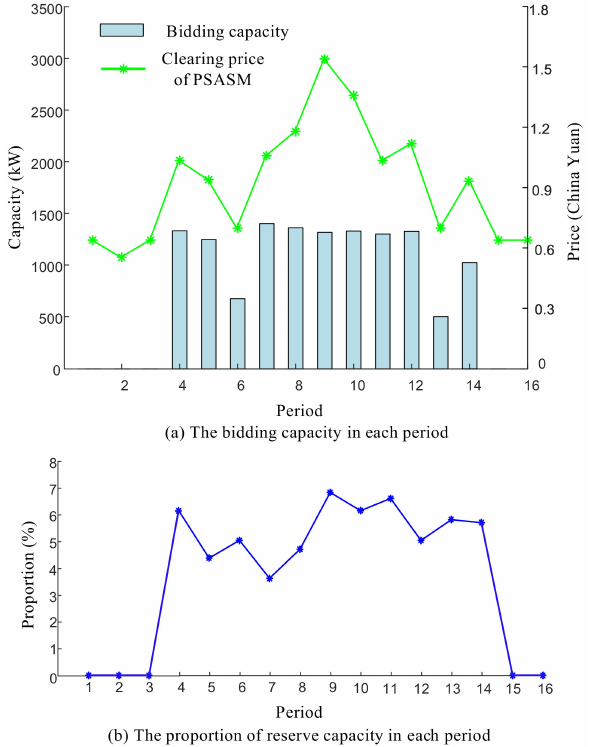
Figure 3. The optimal bidding strategy considering reserve